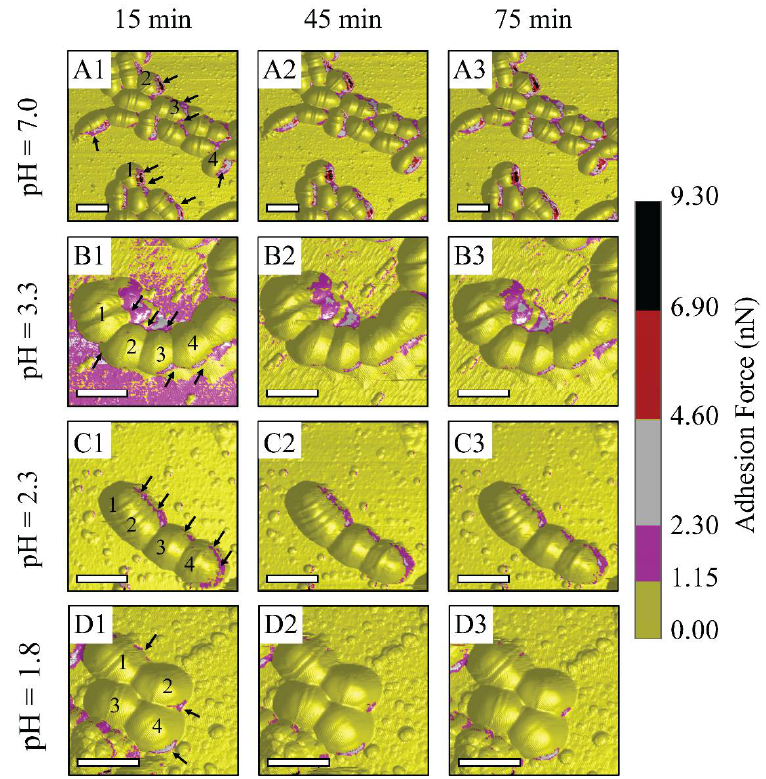
Figure 3. Schematic illustrations of AFM observations on S. mutans biofilm treated under control PBS and controlled-pH citric acid at 15 min intervals: ( A 1– A 3) PBS, ( B 1– B 3) citric acid pH 3.3, ( C 1– C 3) citric acid pH 2.3, and ( D 1– D 3) citric acid pH 1.8. (For 3D adhesion force images, scale bar is 1 µ